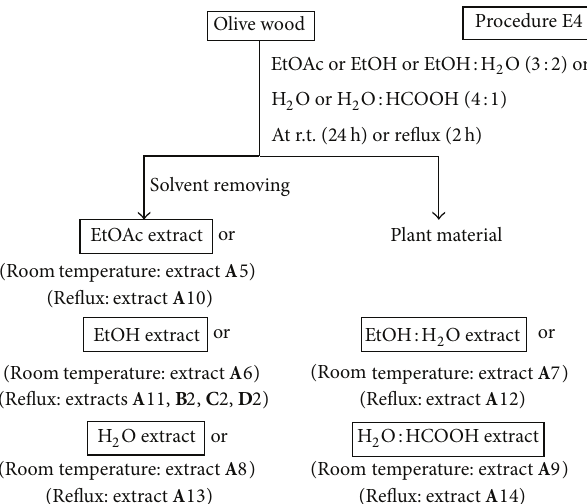
Figure 4: Solvent extractions of olive wood samples A , B , C , and D following procedure